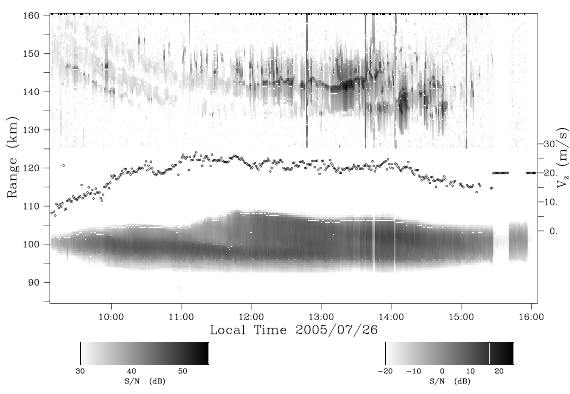
Fig. 1. Range-time-intensity map of electrojet and 150-km echo irregularities plotted in grayscale format according to the scales shown at the lower left and right, respectively. Plotter symbols rep- resent vertical drifts in the valley region inferred from the 150-km echo Doppler